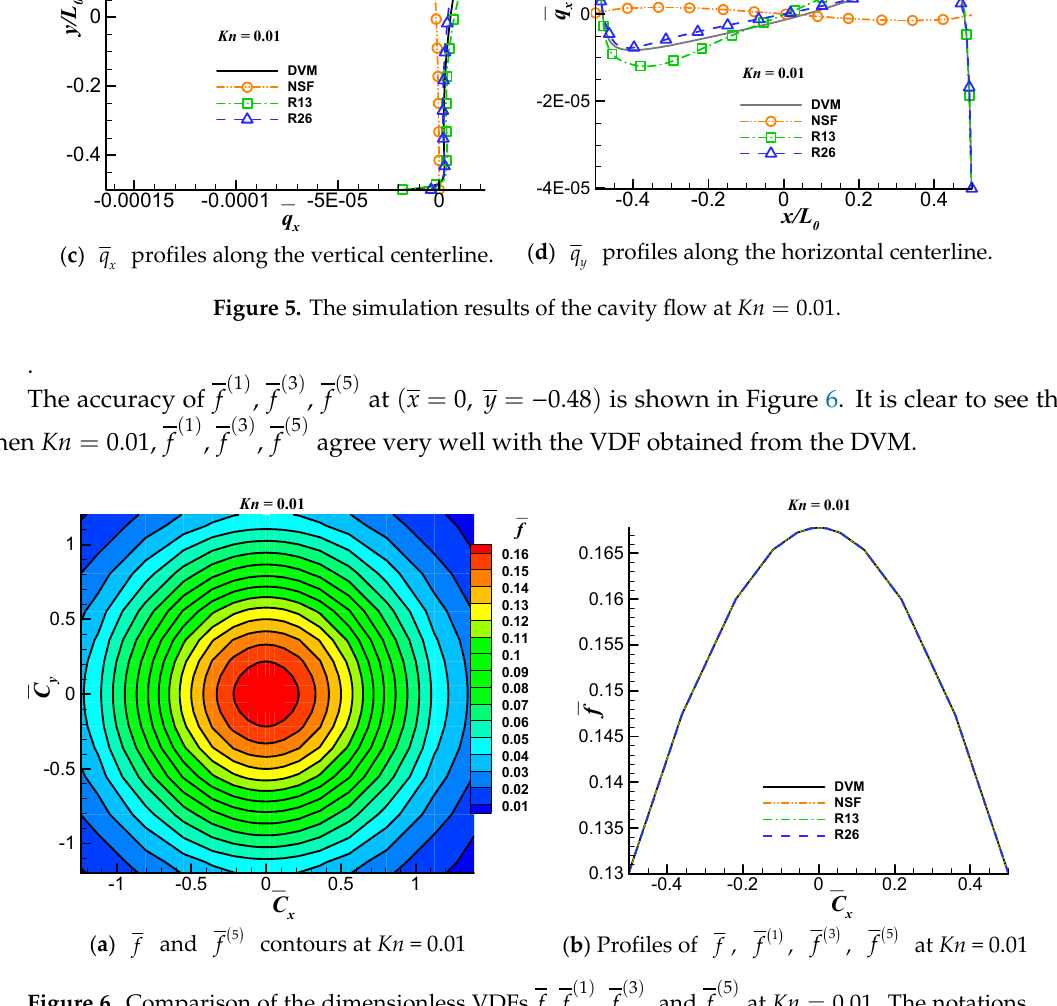
Figure 6. Comparison of the dimensionless VDFs f , . . The f , f have been defined in Figure